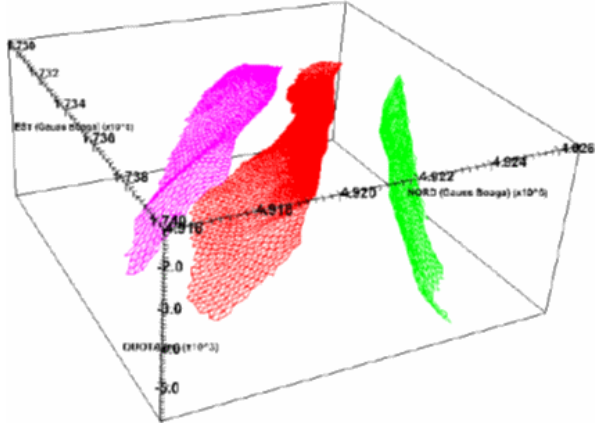
Figure 2. Perspective view of the 3D finite element mesh used in the geomechanical simulations. Table 1. Mechanical properties of the faults derived from lab and in-situ tests on the rock of the Romagna reservoir.